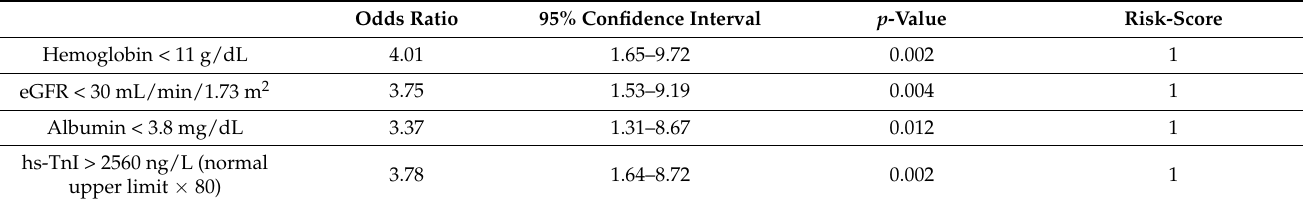
Table 3. Independent predictors for post-discharge death and given